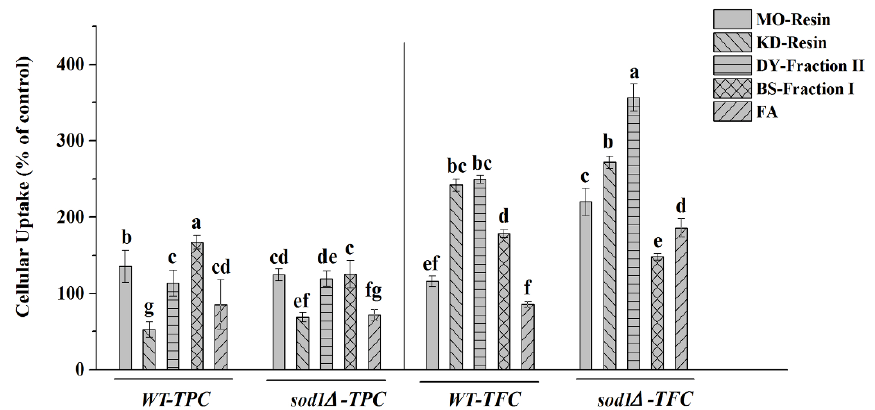
Figure 4. Cellular uptake of herbal teas and green teas components was determined indirectly by measuring the TPC and TFC in the S. cerevisiae incubation media supplemented with 200 µL/mL herbal tea or green teas The data represent the means ± SD of at least three independent experiments. The capital letters mean statistically different results in TPC or TFC at p < 0.05.